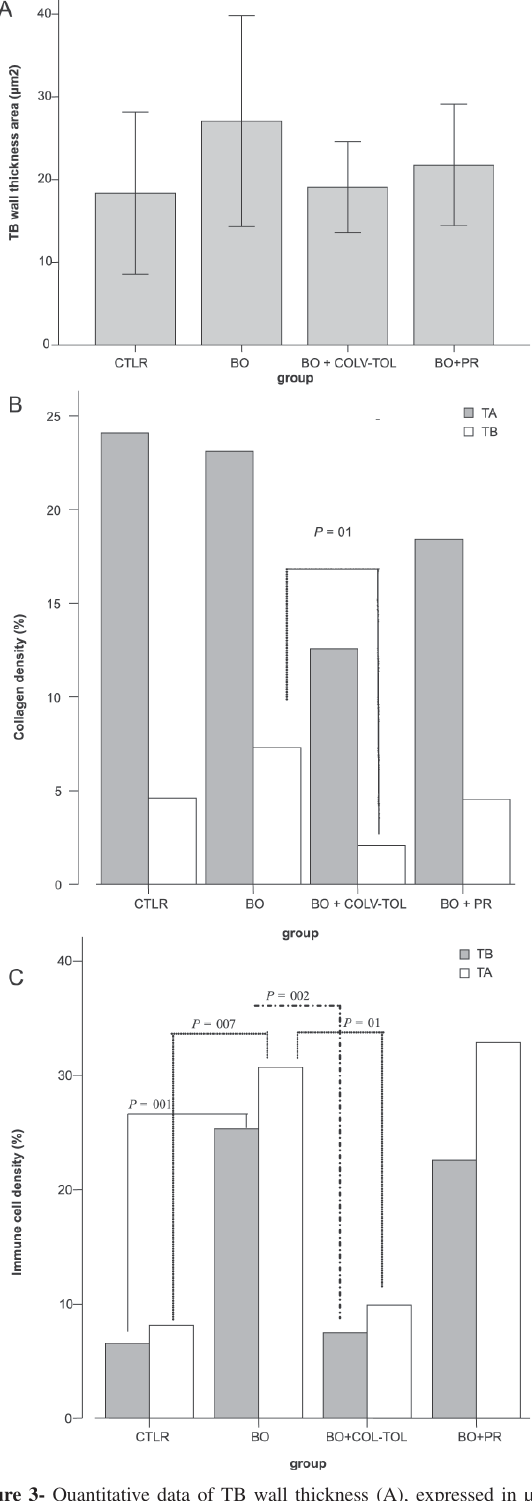
Figure 3- Quantitative data of TB wall thickness (A), expressed in µm 2 . Collagen density (B) and bronchovascular axis immune cells (C), expressed in (%). Decreased TB area and wall thickness seen in BO+COLV-TOL animals compared to the BO group. Collagen density (B) in TB decreased in the BO+COLV-TOL group compared to BO. Peribronchovascular cell density (D) in TB and matched artery reduced in BO+COLV-TOL animals compared to BO. TB- terminal bronchiole; TA- terminal artery.